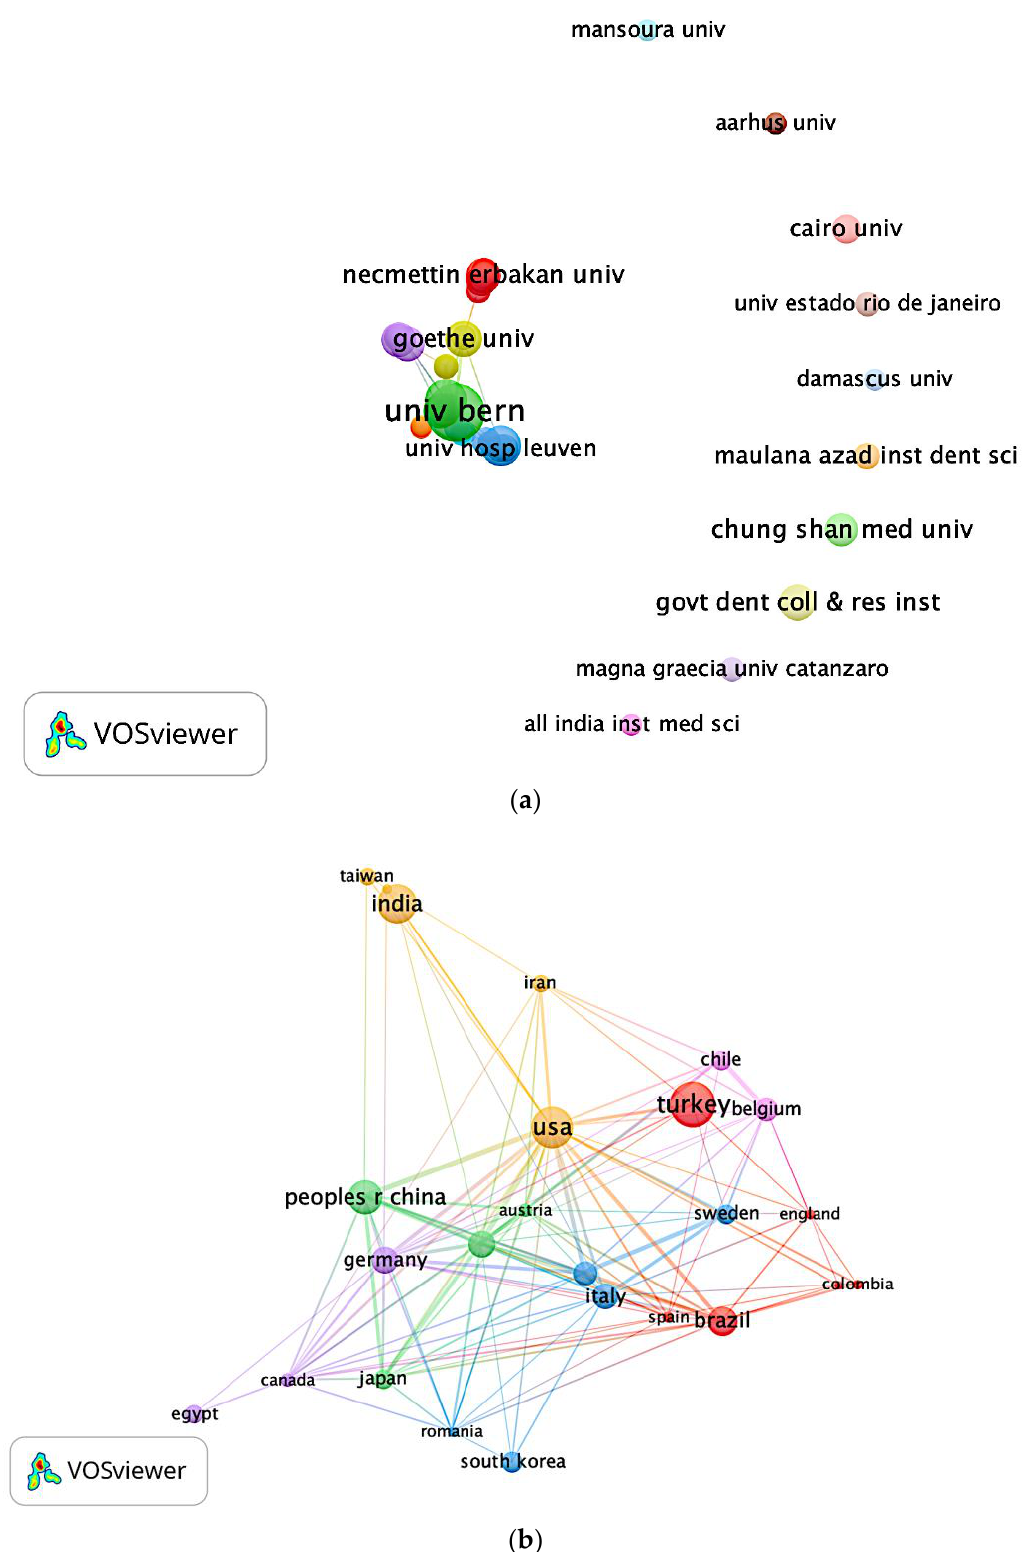
Figure 4. Bibliometric analysis of ( a ) Affiliation network map, and ( b ) Country network map. Different colors denote various clusters, and the size of the circles represents the quantity of publications. The distance between the two circles reveals the relatedness between them.